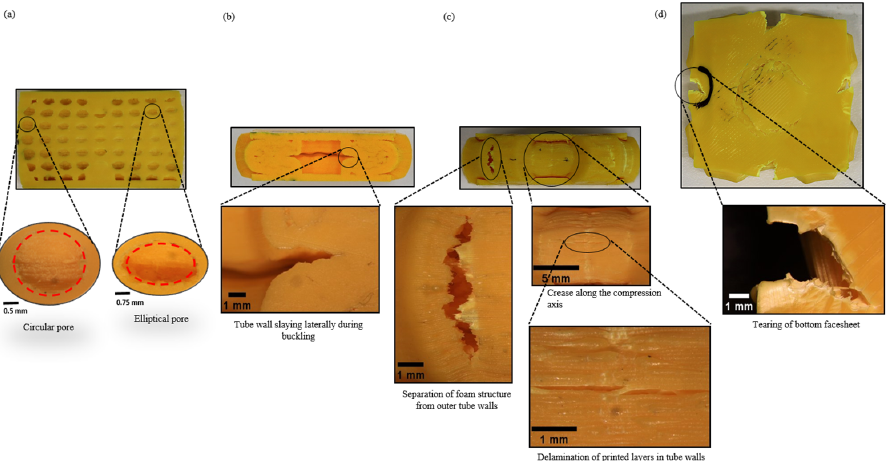
Figure 10. Identified failure mechanisms during energy absorption process captured using stereo microscopy. ( a ) Buckling of pores leading to a change in their shapes. ( b ) Splaying of the inner tube during buckling. ( c ) Separation and delamination of tube walls. ( d ) Tearing occurrence on facesheets at 𝜀 = 0.60 .